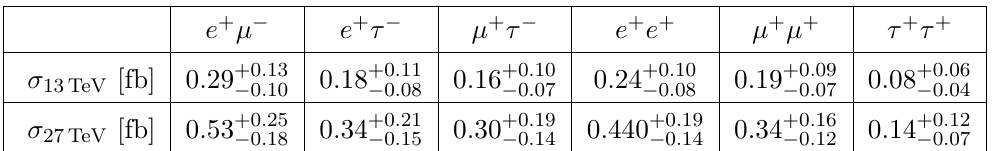
Table 1. Standard Model production cross sections for same sign and opposite sign leptons of di(cid:11)erent (cid:13)avours at 13 and 27 TeV. The uncertainty is obtained by varying the central factorization scale, set to the lepton transverse momentum, by a factor of 2 up and